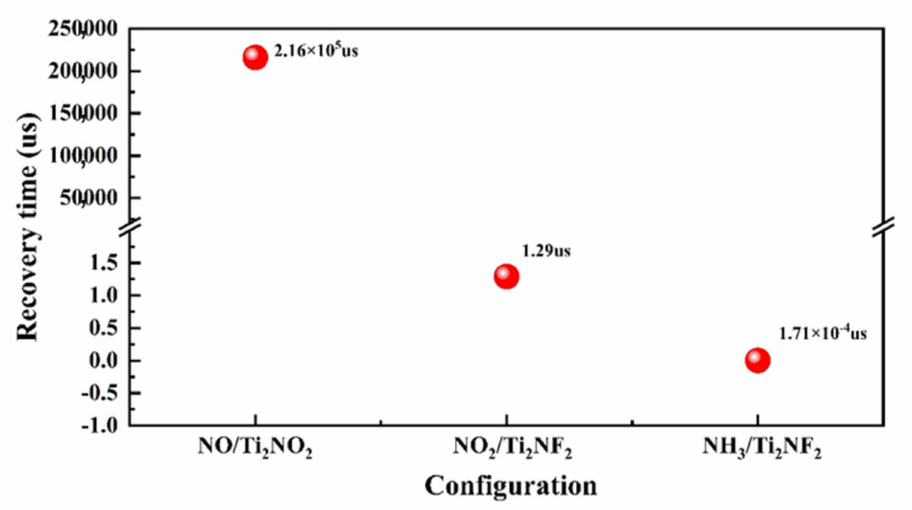
Figure 8. Recovery time of different sensing